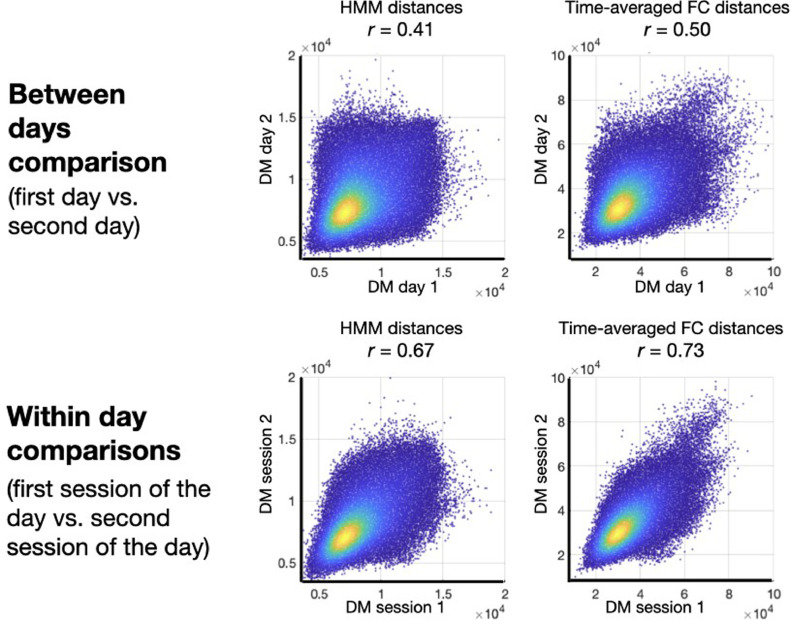
Reproducibility of the estimations between the first and the second day of scanning (top), and between the first session and the second session of each day (bottom), for the HMM (left) and the time-averaged FC representation (right). Each dot corresponds to an element of the DM, i.e. a distance measure between a pair of subjects, and the colour reflect the density of dots. For each panel, the correlation between the DMs (i.e. across dots) is reported as a Pearson's correlation r.